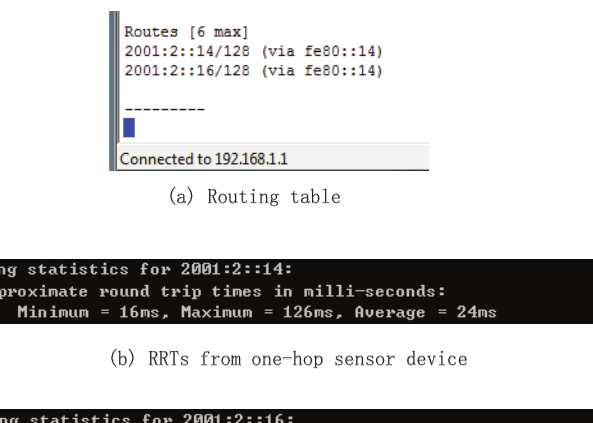
Figure 8. Network topology of prototype system